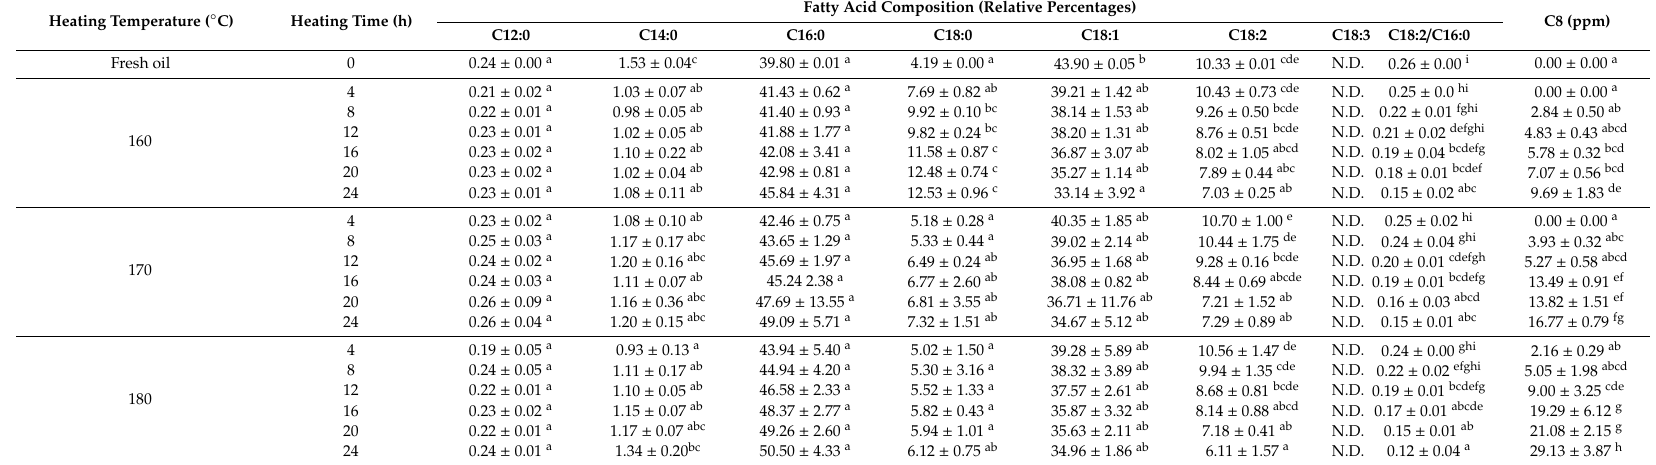
Table 4. Changes in the fatty acid composition in palm olein heated at di ff erent temperatures for di ff erent